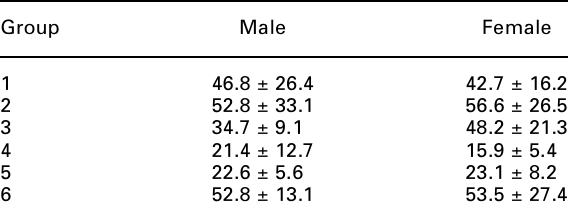
Table 2. Results of blood histamine determination (ng/ml: mean±SEM) according to the sex of infants and